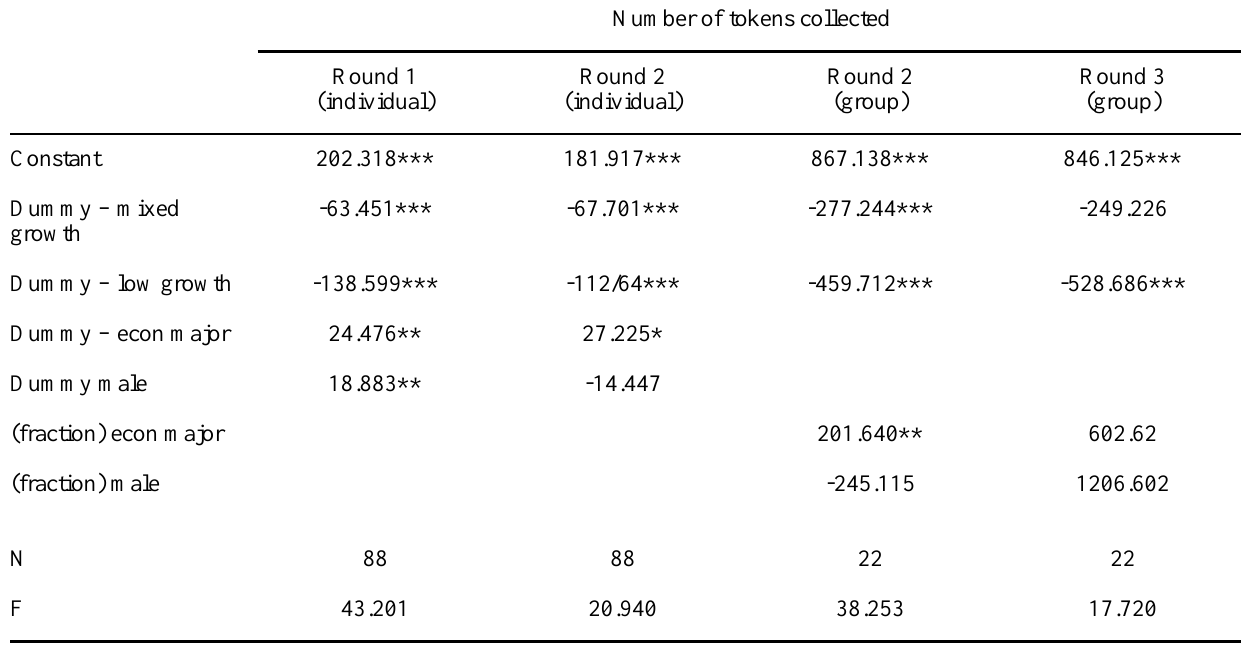
Table 5. The statistical estimation of the relationship between individual and group number of tokens collected with demographic variables gender and